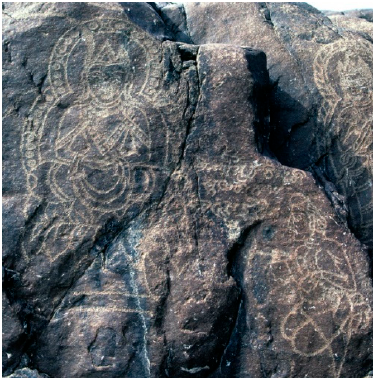
Figure 19. Crowned Buddha with a cape, prior to 630 C.E. Rock carving from Chilas. Commissioned by Si ṃ hota. Photograph courtesy of John C. Huntington.